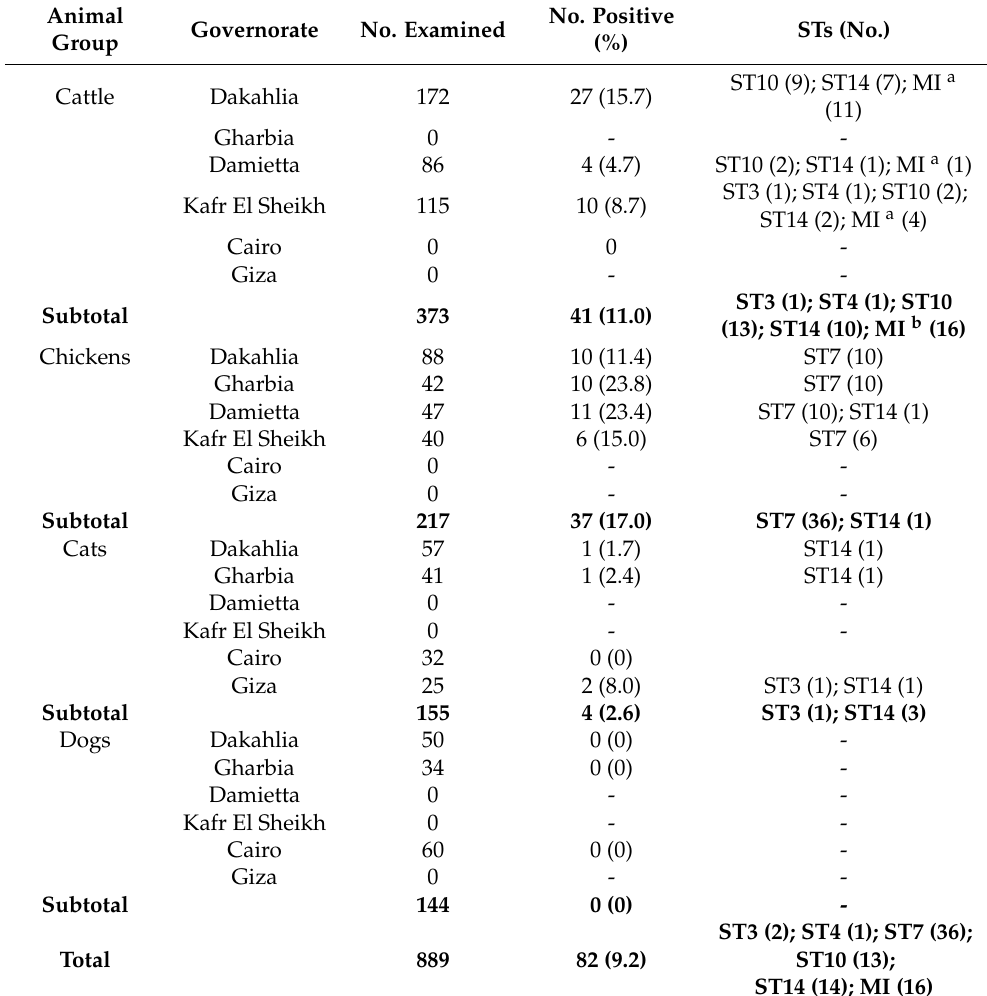
Table 1. Prevalence and ST distribution of Blastocystis sp. in various animal groups sampled in different Egyptian